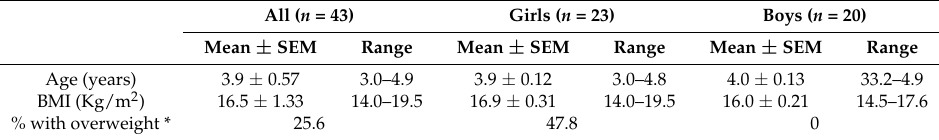
Table 3. Characteristics of children participating in